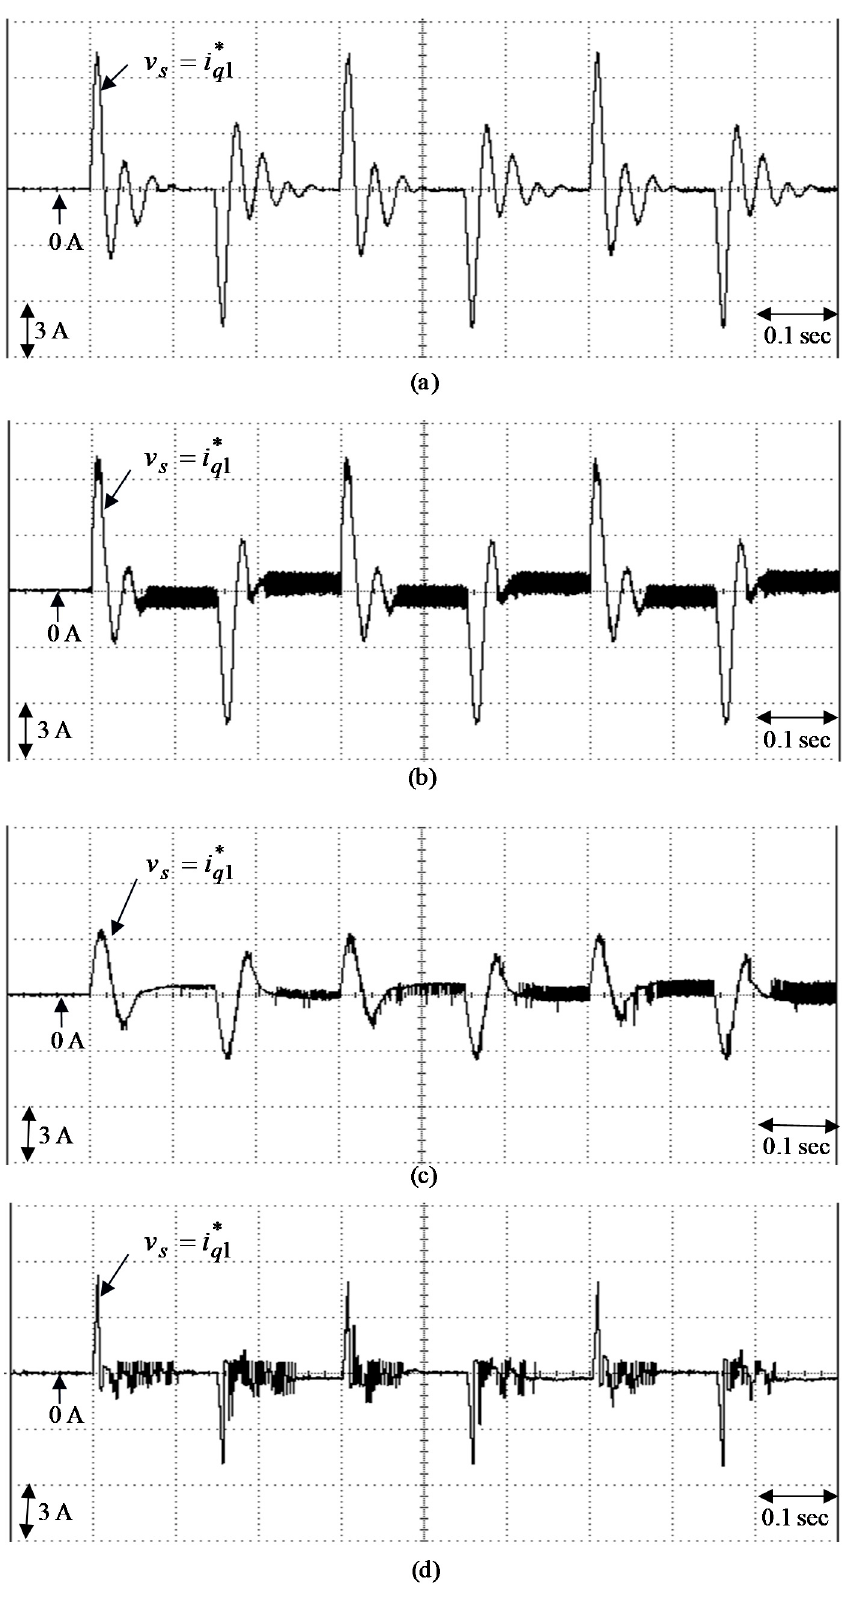
Figure 11. Experimental results of the response of control propulsion in Case R2 ( a ) by utilizing control system W1, ( b ) W2, ( c ) W3, and ( d ) W4.